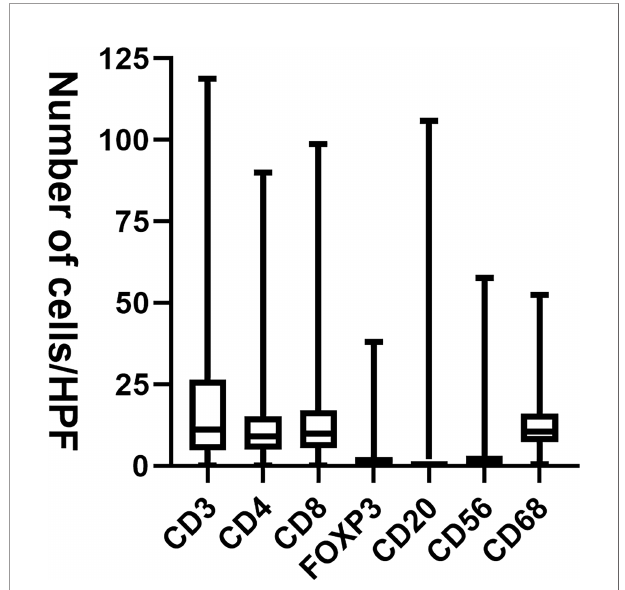
FIGURE 1 | The number of tumor-in fi ltrating immune cells in GISTs. HPF, high power fi